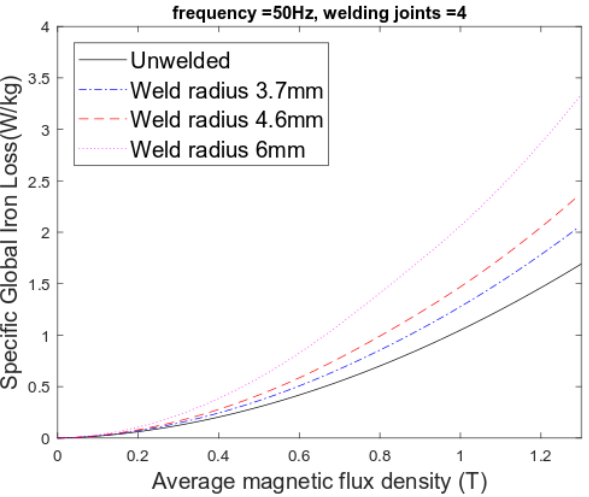
Figure 11. Effect of increasing weld radius on the total core losses when all other model parameters remain